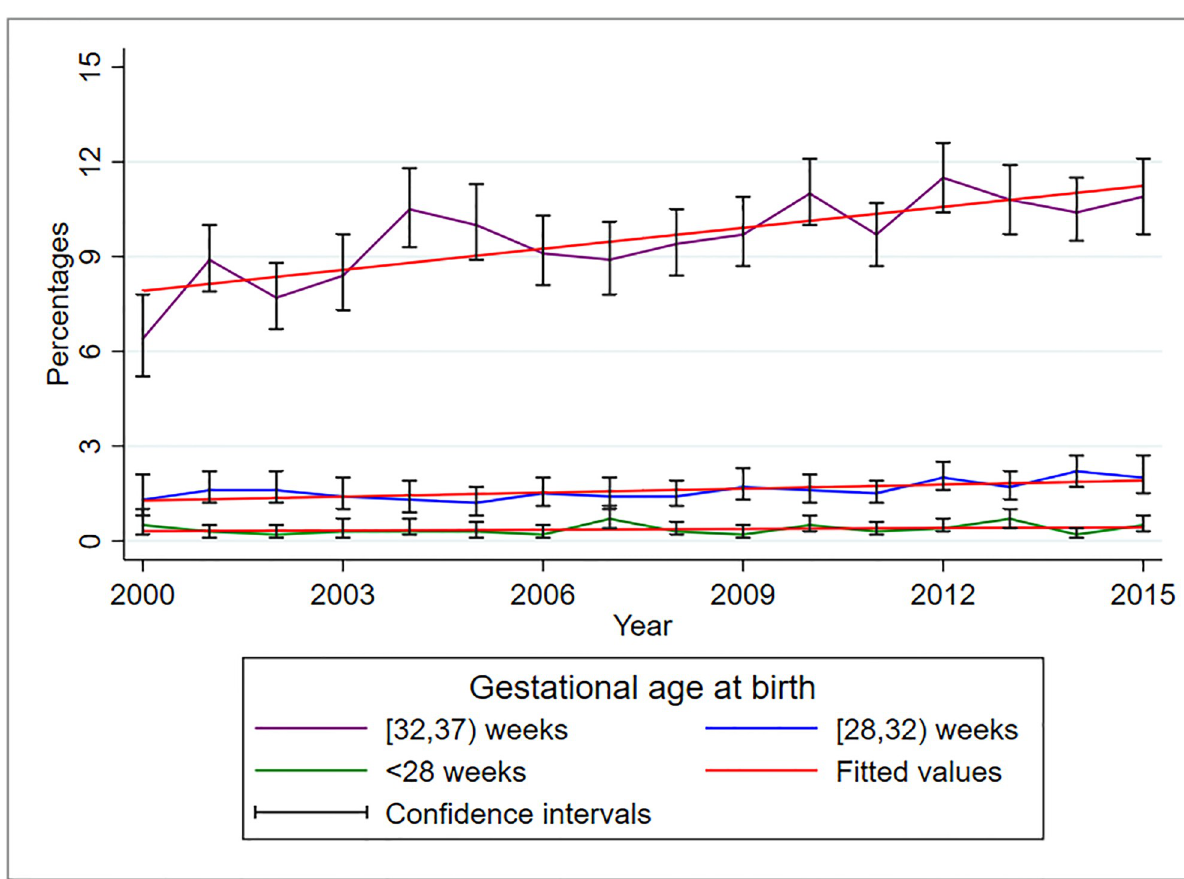
Fig 2. Trends of preterm birth from 2000–2015 in the KCMC medical birth registry (N = 44,117).